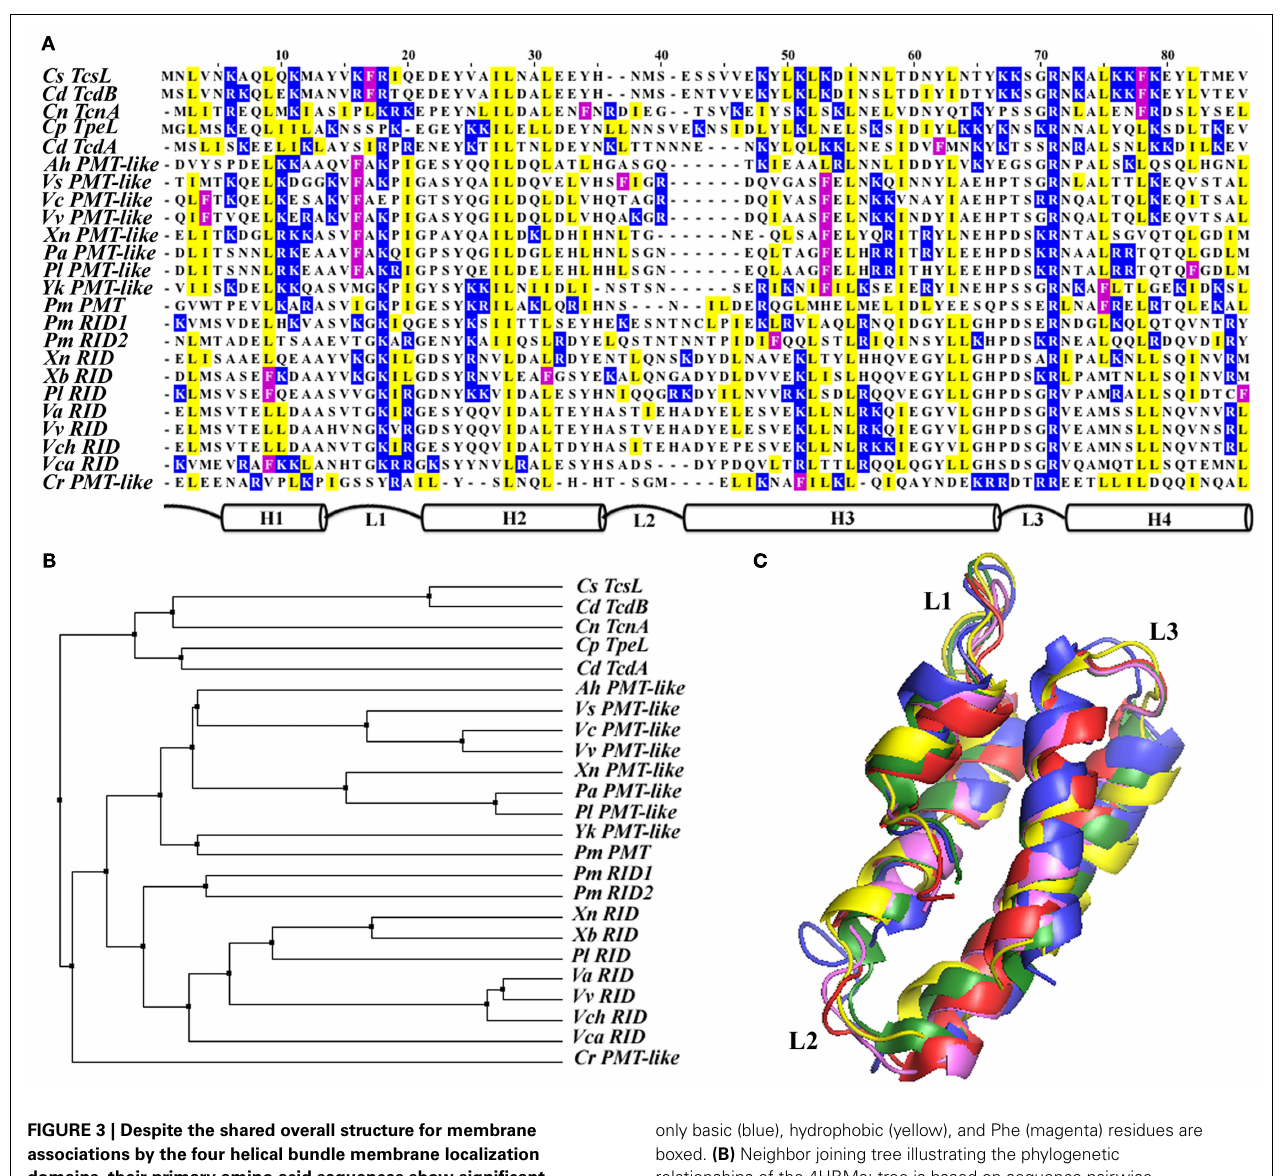
FIGURE 3 | Despite the shared overall structure for membrane associations by the four helical bundle membrane localization domains, their primary amino acid sequences show significant diversity. (A) Pairwise sequence alignment of all 24 of the currently identified 4HBMs organized according to their sequence identity. A schematic representation of the structure of the domains is depicted below alignment.To highlight their locations on either loops or helices,